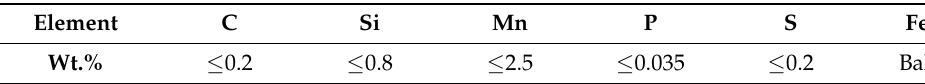
Table 3. Chemical composition of 780 DP steel.